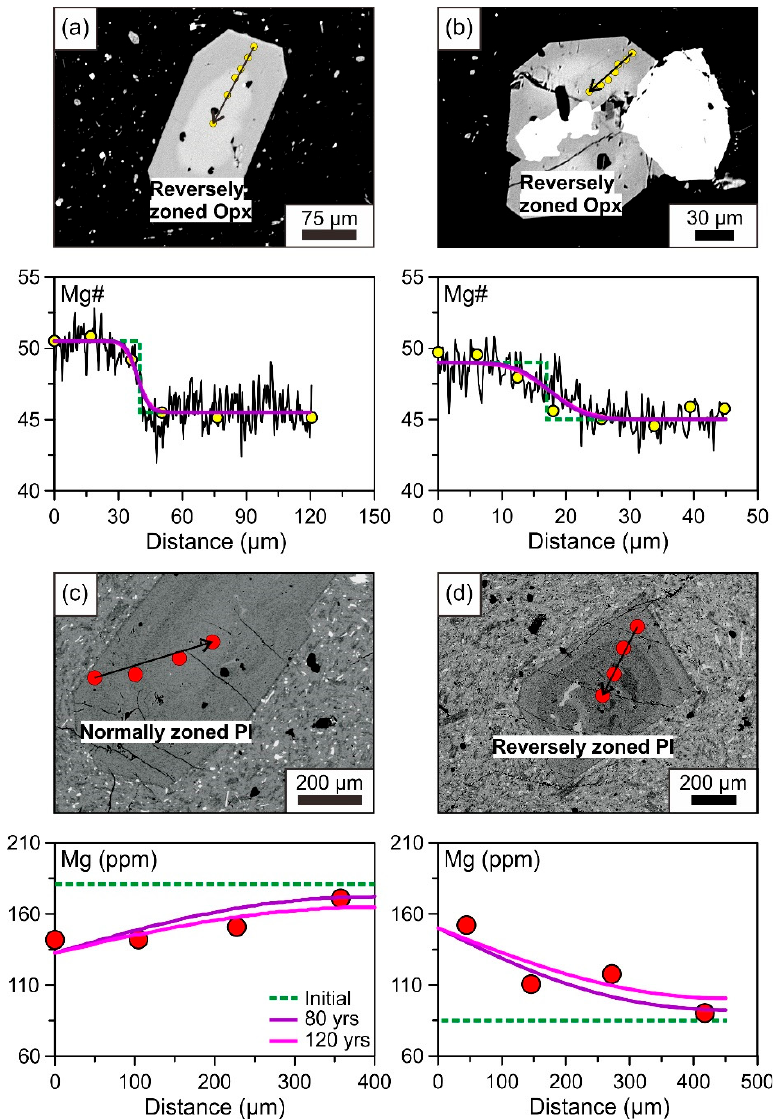
Figure 3. Modeling results of Mg diffusion in the orthopyroxene ( a , b ) and plagioclase ( c , d ) in rhyolite C11. The black curves in ( a , b ) were obtained from the gray values of BSE images. The yellow and red spots denote the data obtained by EMPA and LA-ICP-MS, respectively.